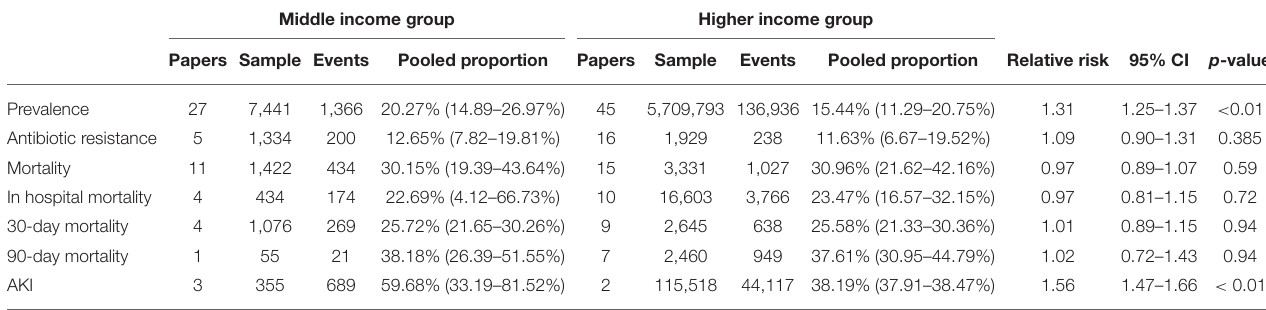
TABLE 4 | Prevalence, antibiotic resistance, and outcomes of SBP subgroup by income level. Middle income group Higher income